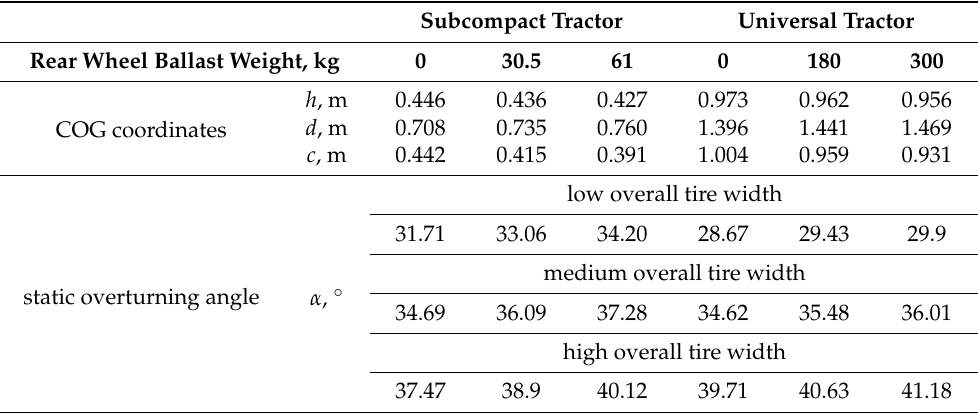
Table 2. Data calculated according to